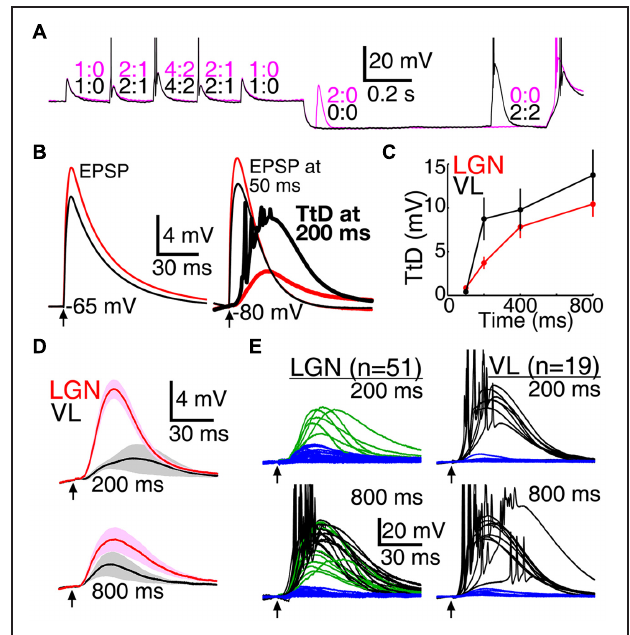
FIGURE 7 | Larger T-type responses in motor than visual thalamus during mimicry of natural synaptic input. (A) Two voltage traces in a single neuron from VL in which an event consisting of two aEPSG occurred at 50 (magenta) or 800 ms (black). Numbers indicate aEPSG input and spike output counts for each aEPSG event. (B) Population mean aEPSPs (thin traces, VL black, LGN red) evoked by one aEPSG from near − 65 mV (left) and after 50 ms near − 80 mV (right), and the isolated TtD at 200 ms (thick traces at right, found by subtracting the voltage response at 50 ms from that at 200 ms). The TtD was larger in VL than LGN despite the EPSP being smaller, and it sometimes evoked spikes (reduced in amplitude by averaging). (C) Population TtD peak amplitude (mean ± SEM) in response to 1 aEPSG as a function of time near − 80 mV. (D) Maximum isolated population TtD (mean ± SEM) that did not cause spikes at 200 (top) and 800 ms (bottom), selected in each cell without regard to aEPSG count. Cells with spikes in response to all aEPSG events were excluded; of 51 and 19 cells in LGN and VL, respectively, 51 and 12 contributed data at 200 ms, and 36 and 9 at 800 ms. Arrows indicate time of aEPSG onset. (E) Isolated TtD from each individual neuron in response to one aEPSG at 200 (top) and 800 ms (bottom) in LGN (left) and VL (right; averaged across four repetitions per cell). Each TtD was categorized according to whether it evoked one or more spikes (black; in response to at least one of four repetitions), was large ( > 15 mV) but did not evoke spikes (green), or was small (blue). All large TtD in VL caused